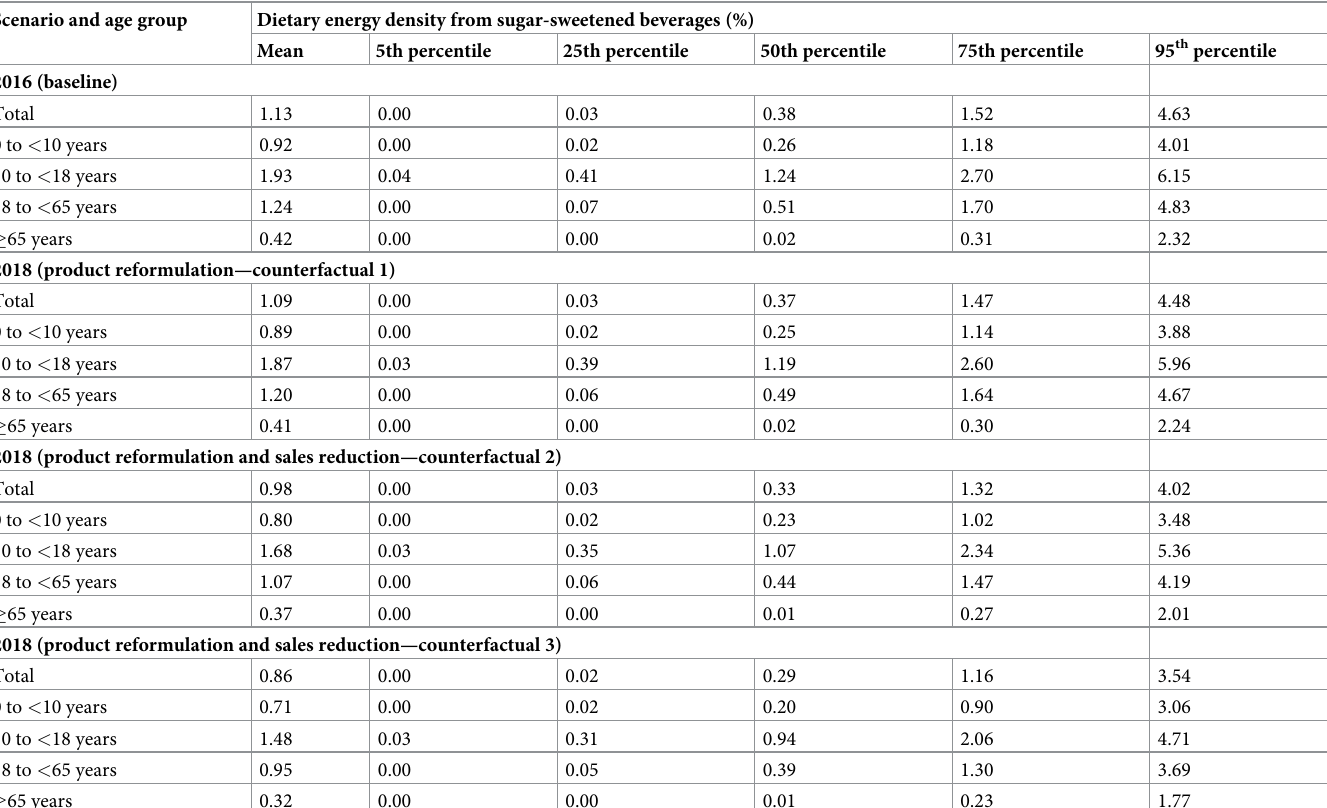
Table 1. Dietary energy density from sugar-sweetened beverages in 2016 (baseline) and 2018 (counterfactual scenarios), by age group. Scenario and age